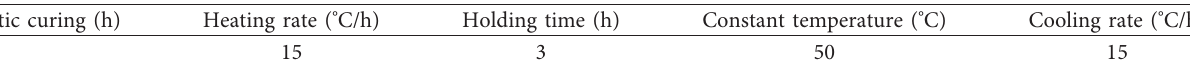
Table 2: Steam curing